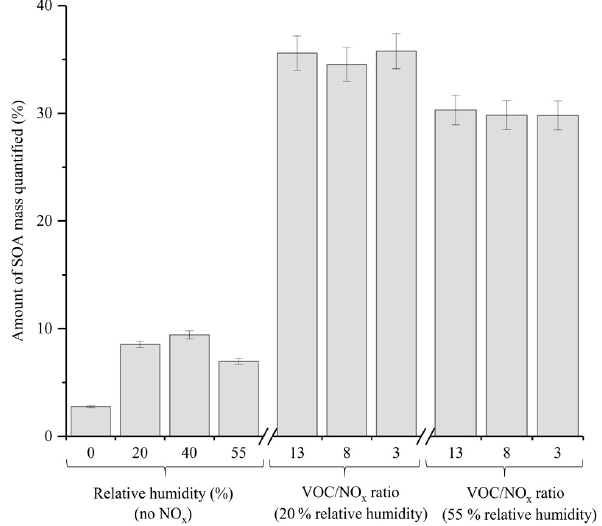
Figure 7. Total amount of SOA mass quantified using the generated standards in the α -pinene experiments shown in Table 1. Error bars represent the propagated uncertainty in the slope of the calibrations used to quantify each SOA component.